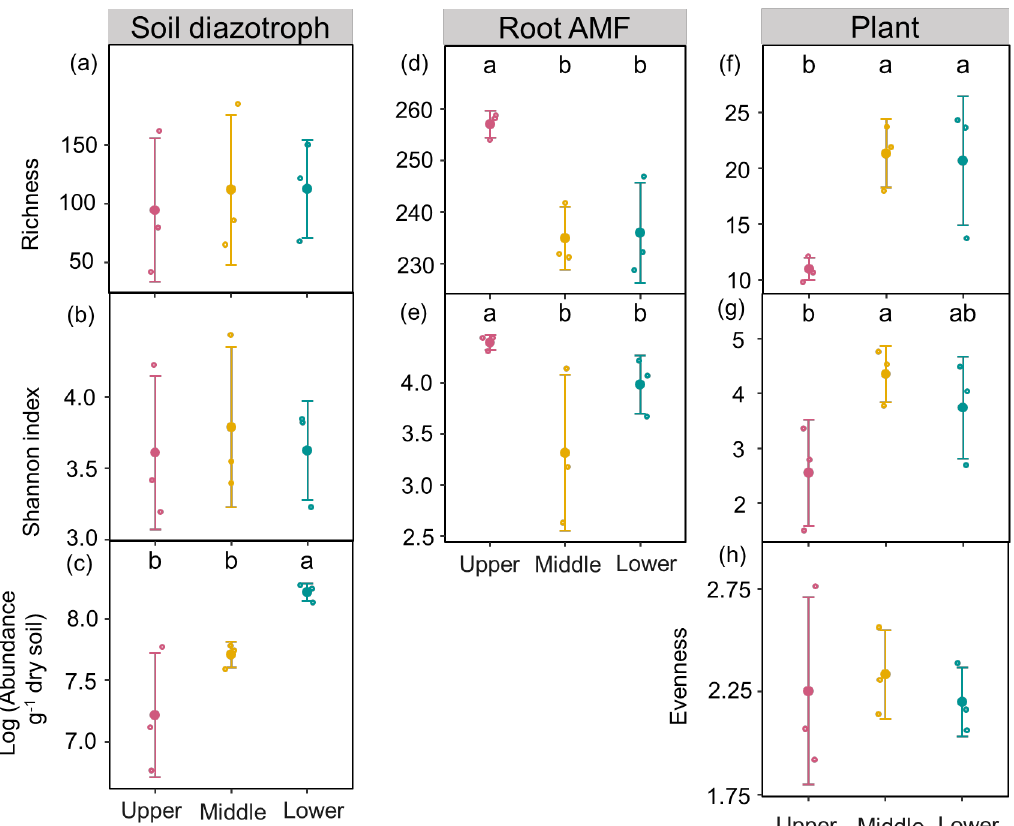
ences at p < 0.05 among upper, middle, and lower slope positions.